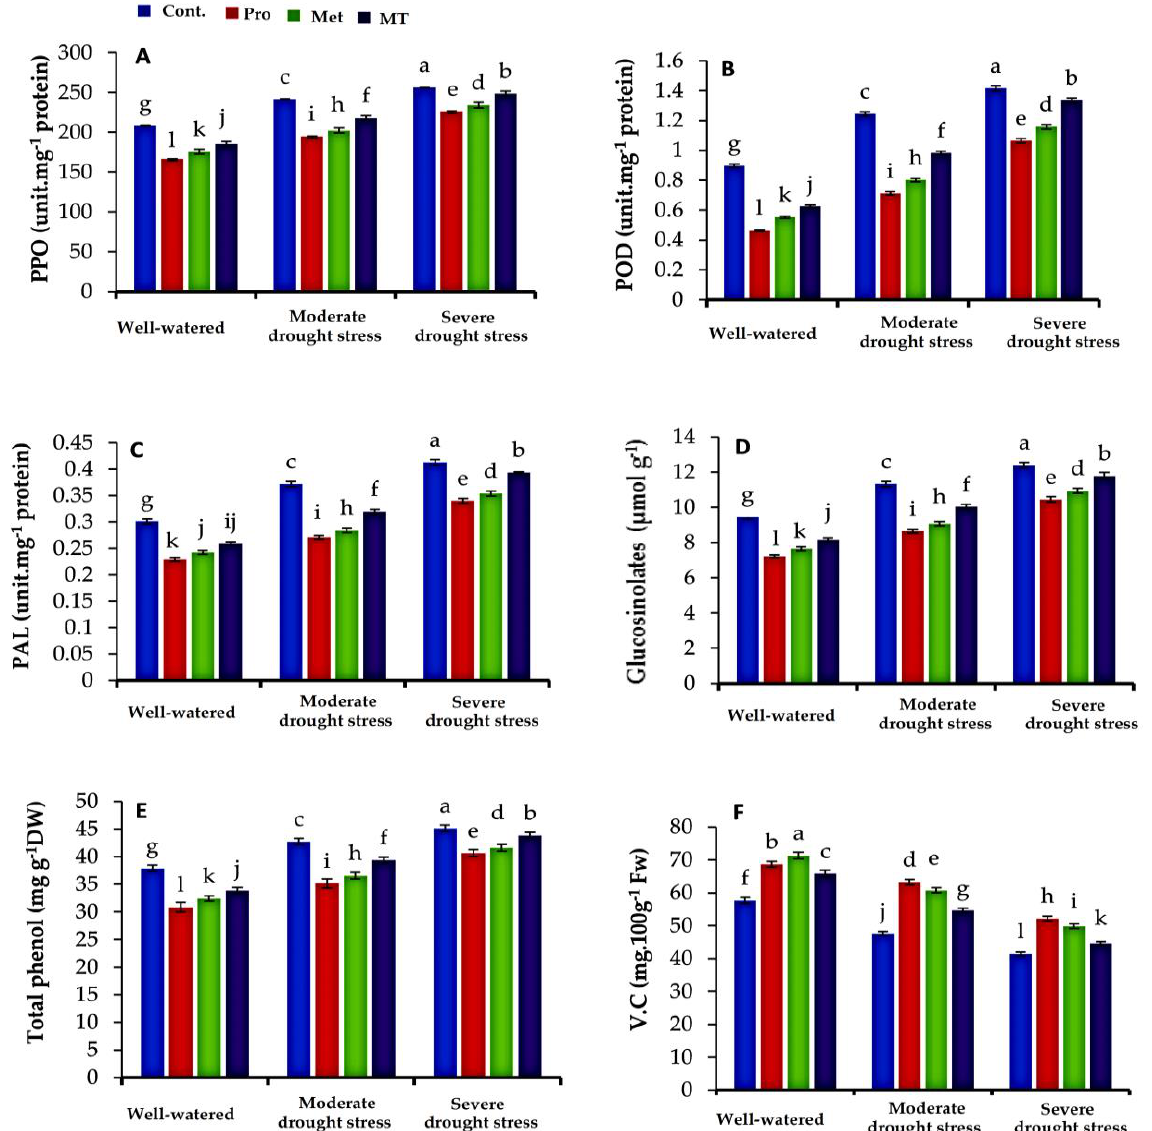
Figure 3. Impact of interaction between treatments (proline, methionine, and melatonin) and water levels on polyphenol oxidase (PPO, ( A )), peroxidase (POD, ( B )), and phenylalanine ammonia-lyase (PAL, ( C )), glucosinolates ( D ), total phenols ( E ) and vitamin C ( F ) of cauliflower plants grown under different levels of irrigation water. Bars indicates standard error (SE) of the means (n = 6). Different letters indicate significant differences between the treatments at according to Tukey’s multiple range test ( p ≤